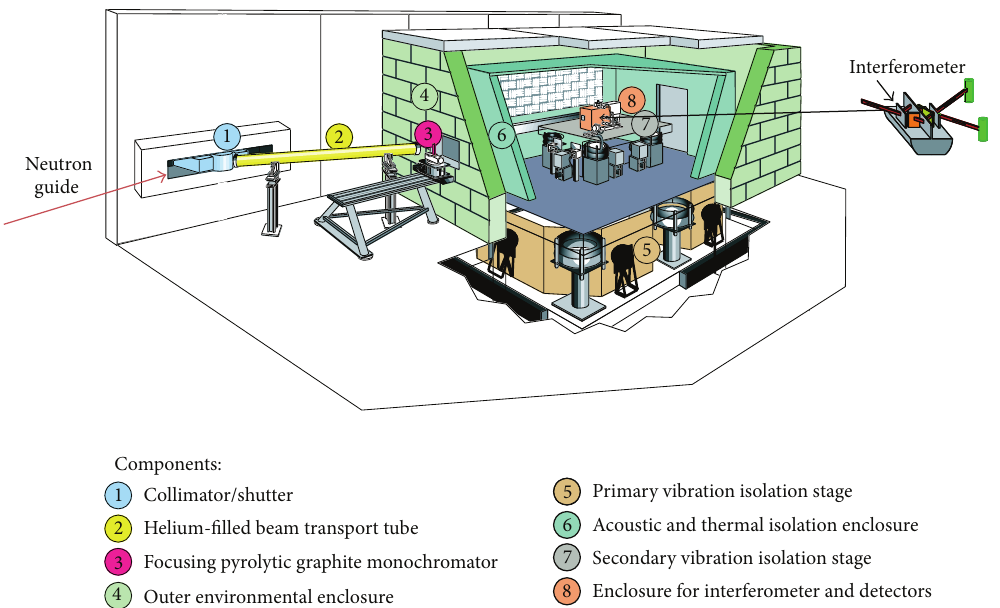
Figure 1: Schematic of the Neutron Interferometry and Optics Facility for Neutron Research at the National Institute of Standards and Technology. The isolated 40,000 kg room is supported by six air-springs. The system uses active vibration control to eliminate vibrations above 0.5 Hz. The temperature of the interferometer enclosure is stabilized to 5 mK precision to improve long-term phase stability (diagram also appeared in [16]).